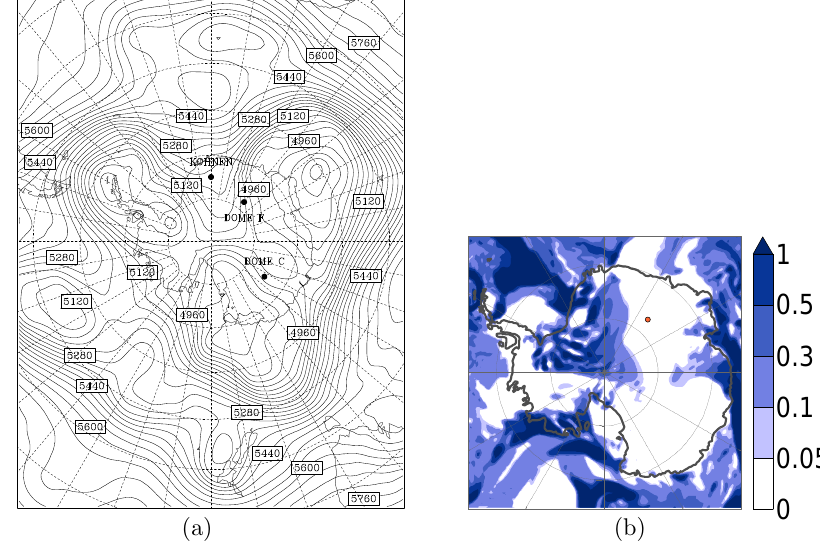
Figure 8. Example for the event Southerly Flow; (a) 500hPa geopotential height from AMPS, 1 October 2003 00:00UTC, (b) 6h precipita- tion in mm from AMPS, 1 October 2003 00:00UTC.